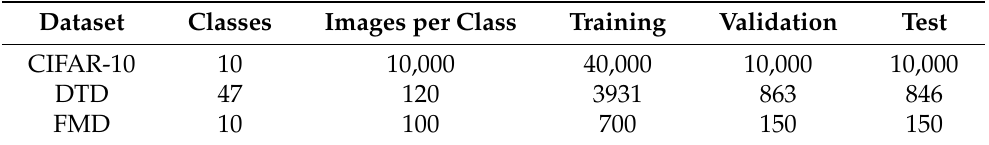
Table 2. The number of images per